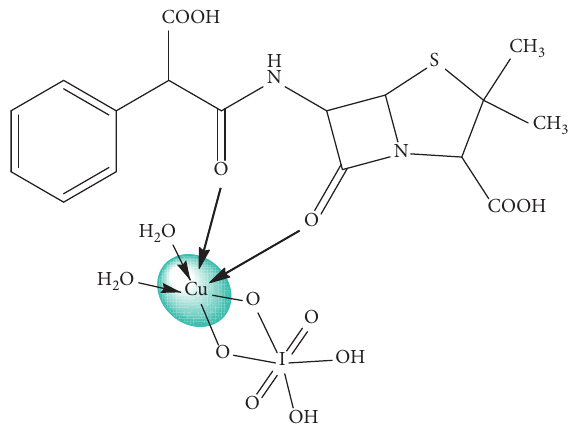
Scheme 1: Detailed scheme for uncatalyzed oxidation of CRBC by DPC (III).